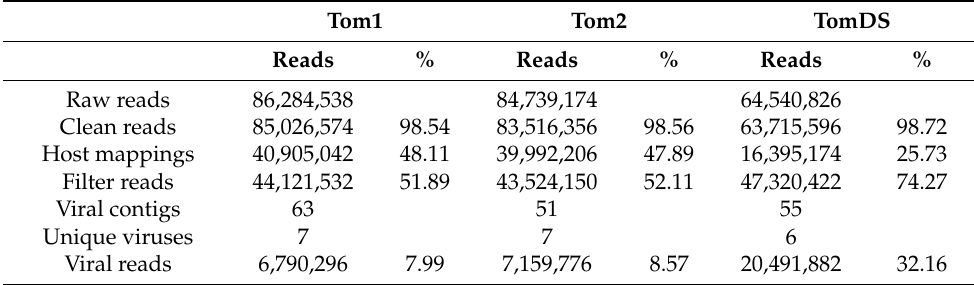
Table 2. Summary of sequencing and mapping results.